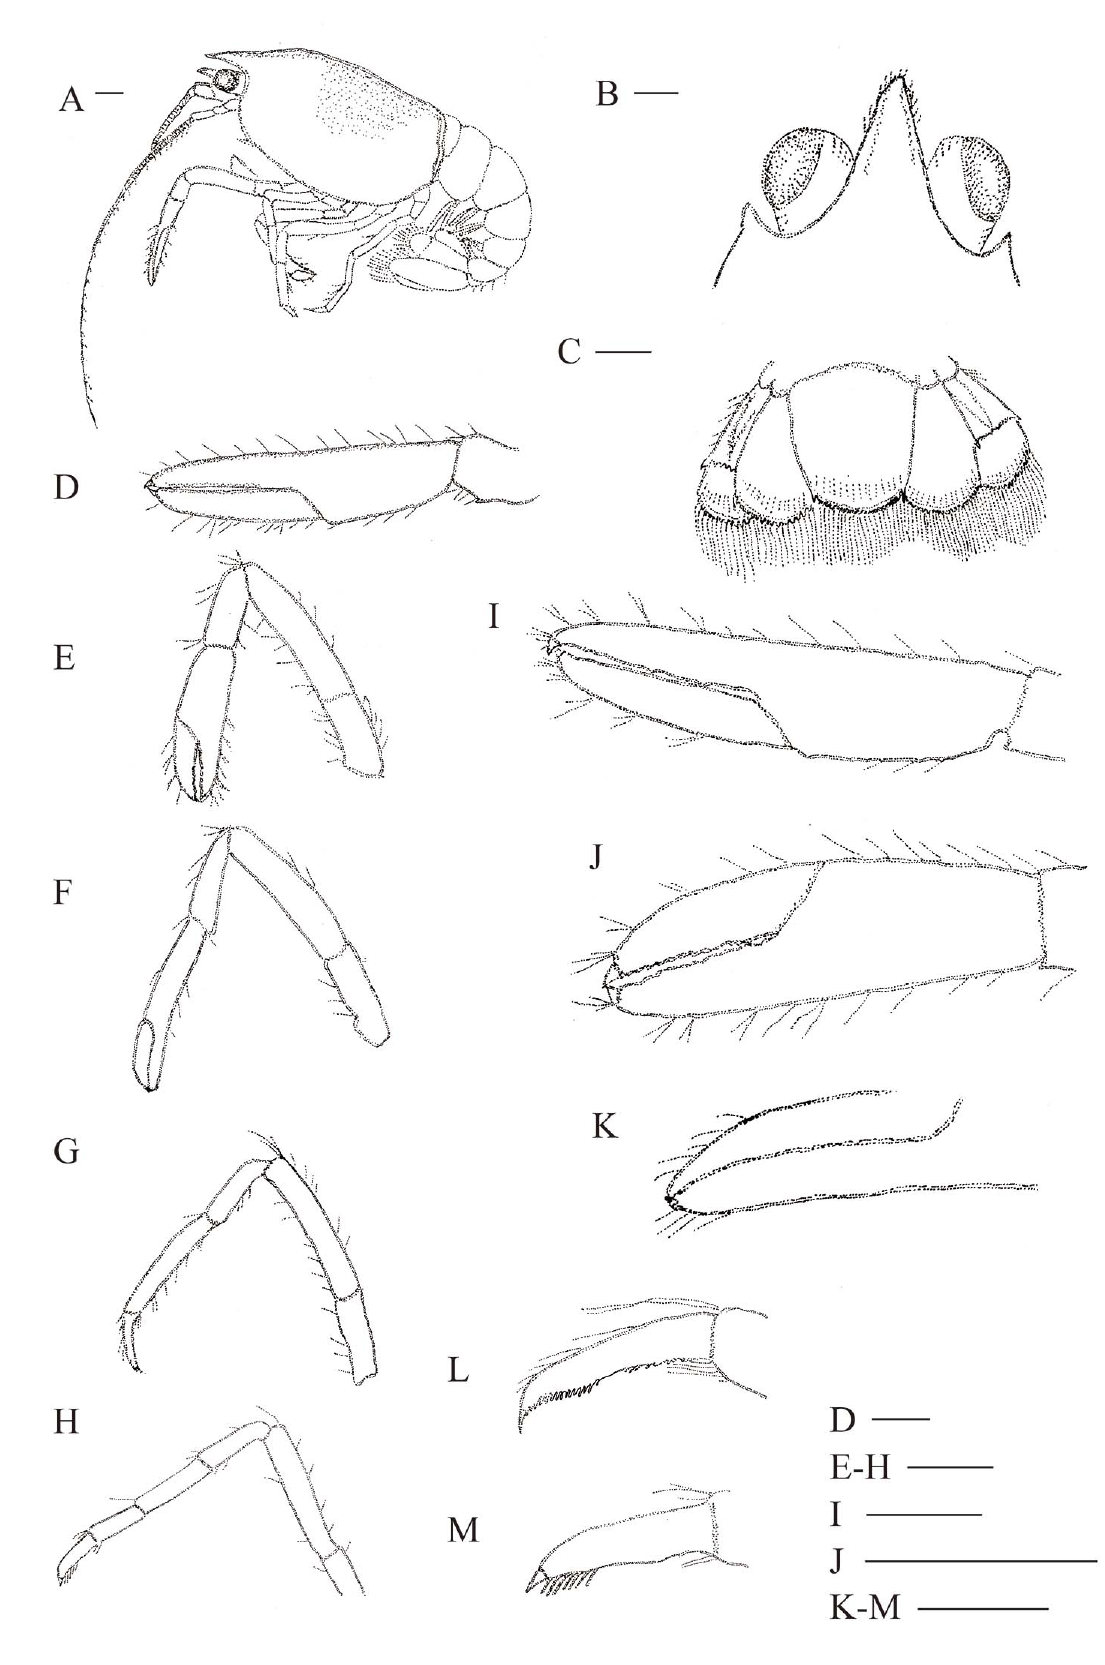
Figure 23. Juvenile Stage III of Cherax destructor . ( A ) Habitus, lateral view; ( B ) eyes and rostrum, dorsal view; ( C ) tail fan, dorsal view; ( D–H ) pereiopods 1–5, dorsal or lateral view; ( I–M ) distal segments of pereiopods 1–5, dorsal or lateral view. Scale bars: 0.25